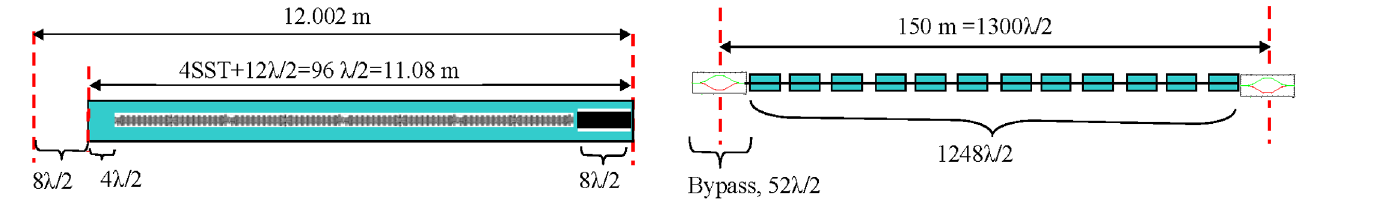
FIG. 13. (Color) A 12 cryomodule rf zone.